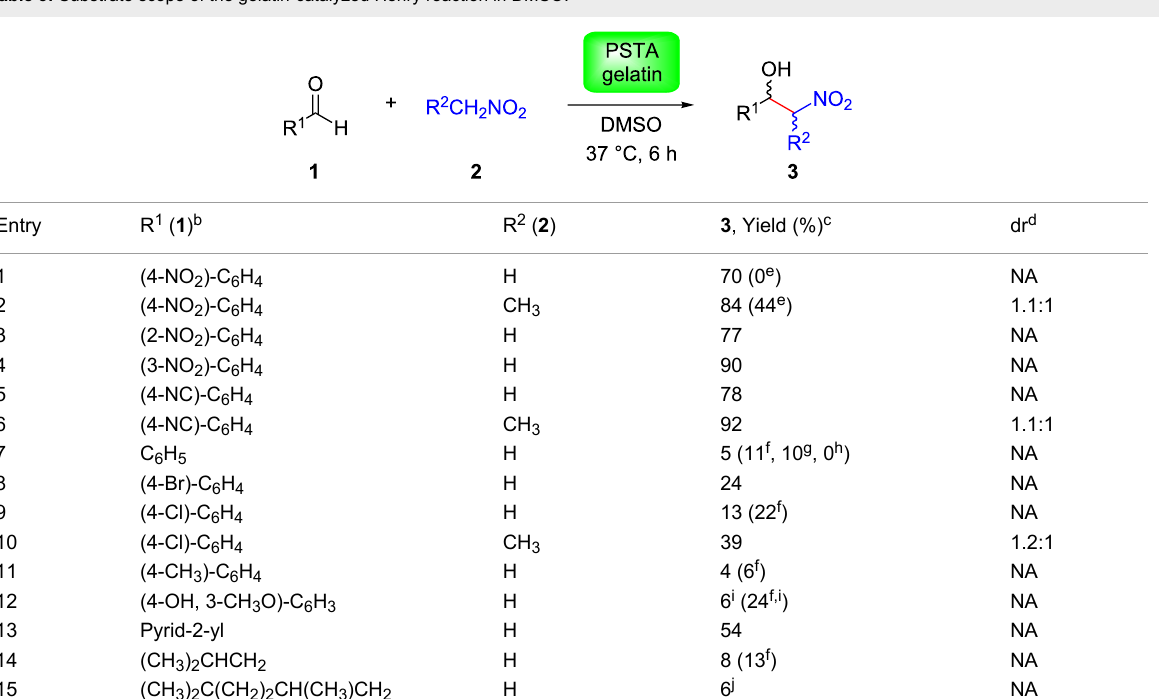
Table 3: Substrate scope of the gelatin-catalyzed Henry reaction in DMSO. a